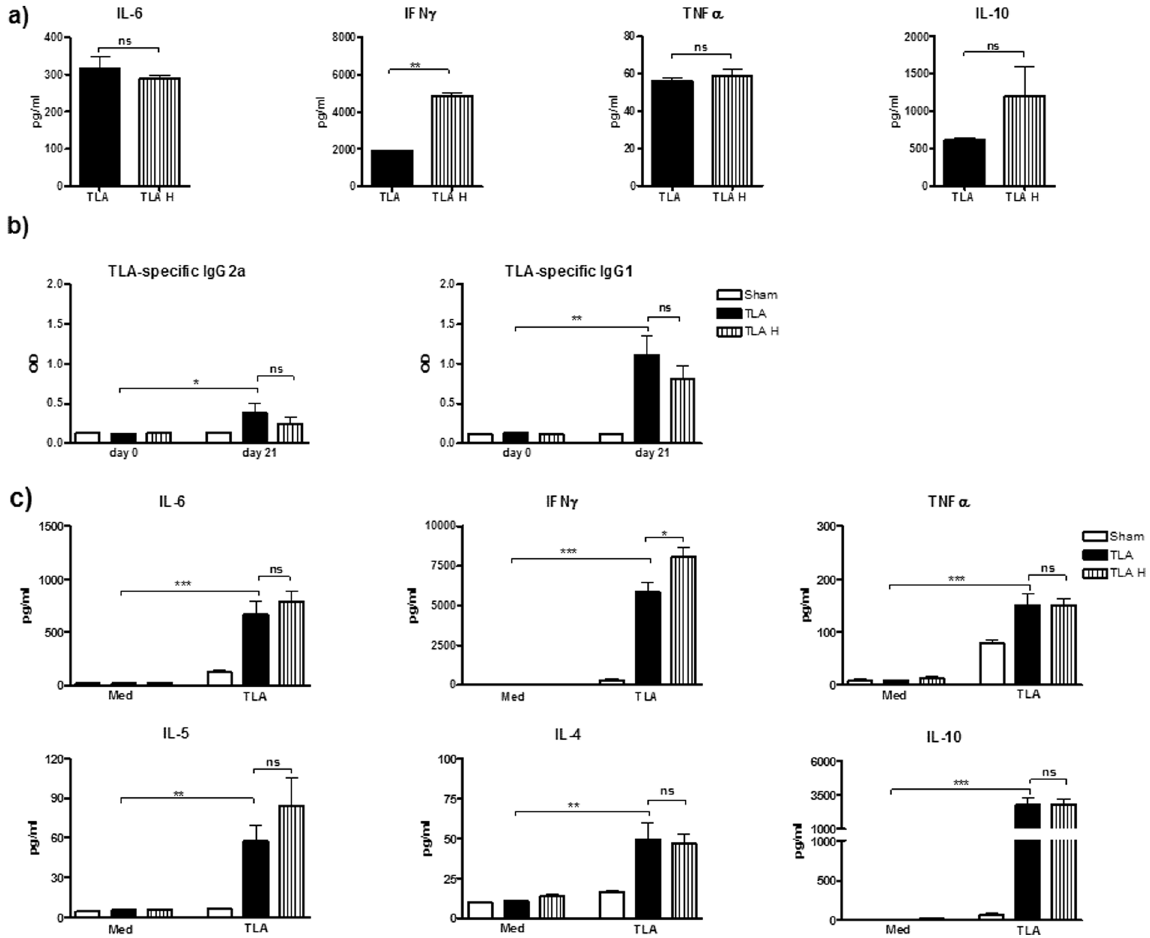
Figure 6. Impact of heat-treatment on the immunomodulatory properties of TLA. Splenocytes of naïve mice were cultured with 5 µ g of native TLA (TLA) or heat-inactivated TLA (TLA H) for 72 h ( a ). Mice were immunized intraperitoneally with 10 µ g TLA in alum (TLA group) or 10 µ g of heat-inactivated TLA (TLA H group) on days 0 and 10. Controls received PBS in alum (Sham group). Serum and spleens were collected on day 21. TLA-specific IgG2a and IgG1 in serum were assessed by ELISA ( b ). Spleen cell cultures were restimulated with 5 µ g/ml TLA or with medium only (Med) and incubated for 72 h. Levels of cytokines in culture supernatants were determined by ELISA ( c ). Data are representative of three experiments (n = 5 mice per group). Results of ANOVA test: * P < 0.05, ** P < 0.01, *** P <